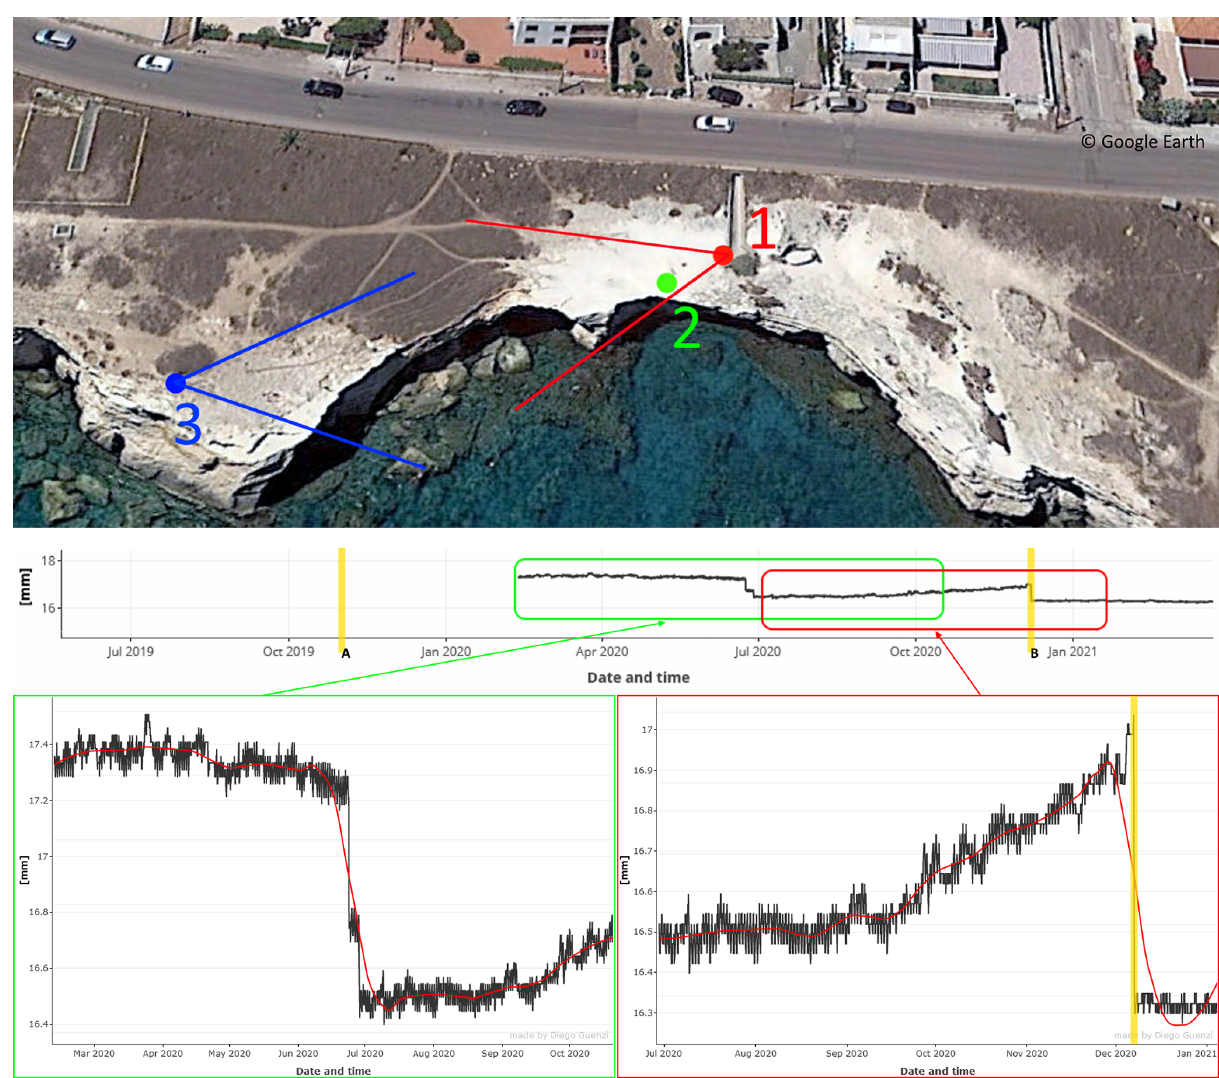
Figure 1. At the top, plan of the monitored cliff area (taken from © Google Earth) – in red (marked with “1”) the main camera position and the Raspberry Camera Module field of view; in blue (marked with “3”) the secondary camera; the green dot marked with “2” is the position of the crack meter. At the bottom, the crack-meter data – in the green box the first period of data obtained using the automatic crack meter (from 12 February 2020 up to 20 October 2020). In the red box the second period of data of the same crack meter (going from 29 June 2020 to 4 January 2021). Two main rockfalls have been noticed in this period and have been marked with the “A” and “B” yellow